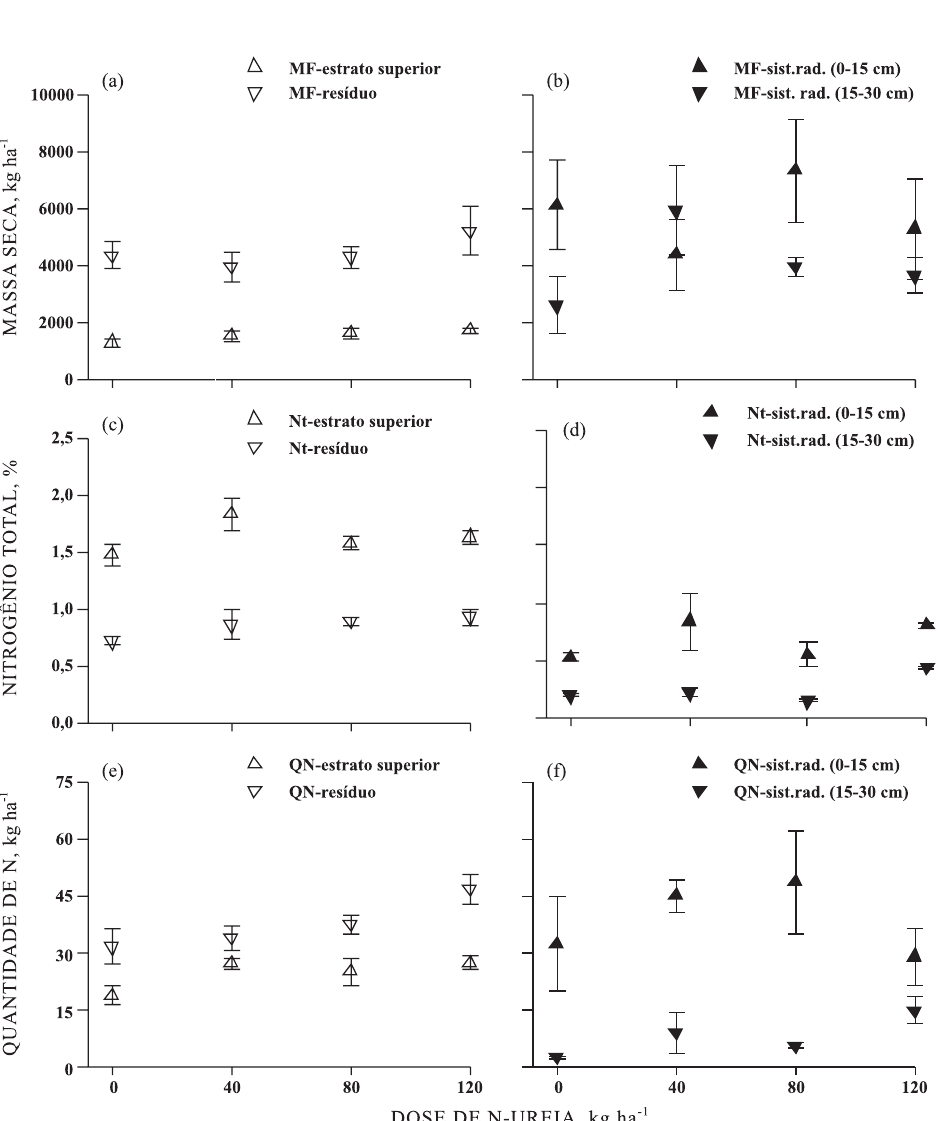
Figura 1. Produção de massa seca de forragem (MF), teor de N total (Nt) e quantidade de N (QN) na parte aérea (estrato superior e resíduo pós-pastejo) e no sistema radicular (profundidades de 0-15 e 15-30 cm) de capim-tanzânia adubado com 0, 40, 80 e 120 kg ha -1 de N-ureia. As barras verticais indicam o erro- padrão da